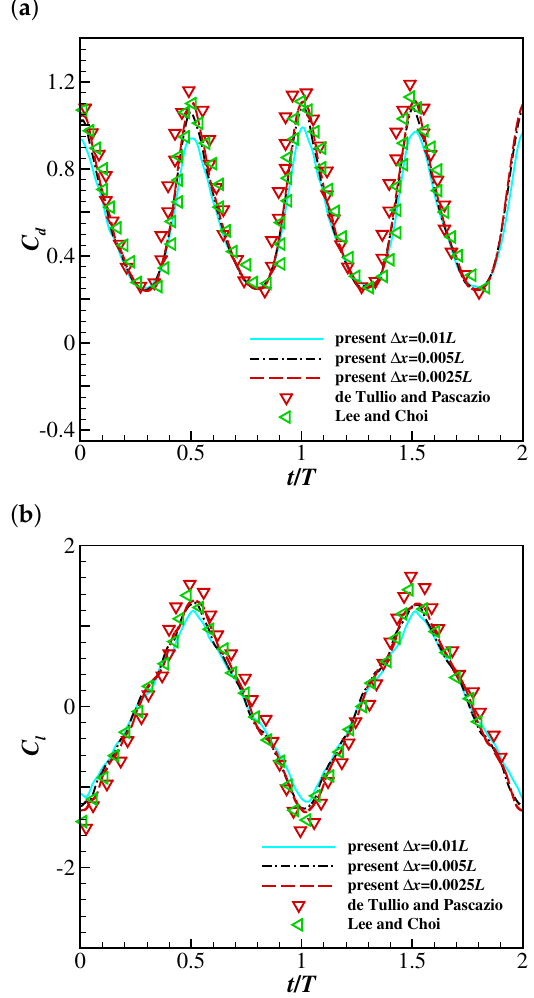
Figure 3. A 2D filament flapping in a Newtonian uniform flow: the time histories of ( a ) the drag coefficient and ( b ) the lift coefficient of the flapping filament at Re =